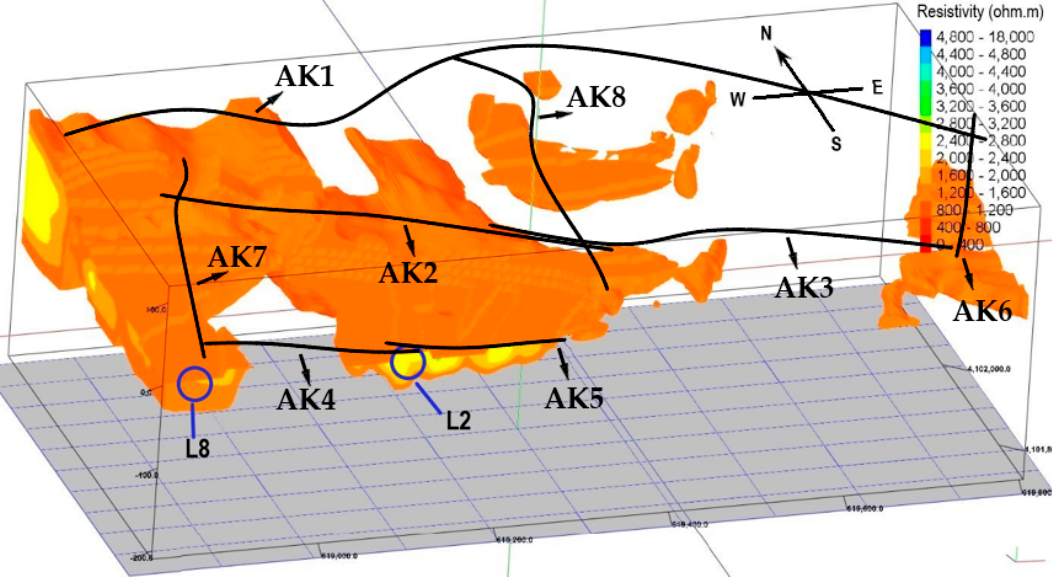
Figure 10. The area with resistivity values higher than 1000 ohm-m in the 3D model. L2 and L8 springs are shown in blue cycles.